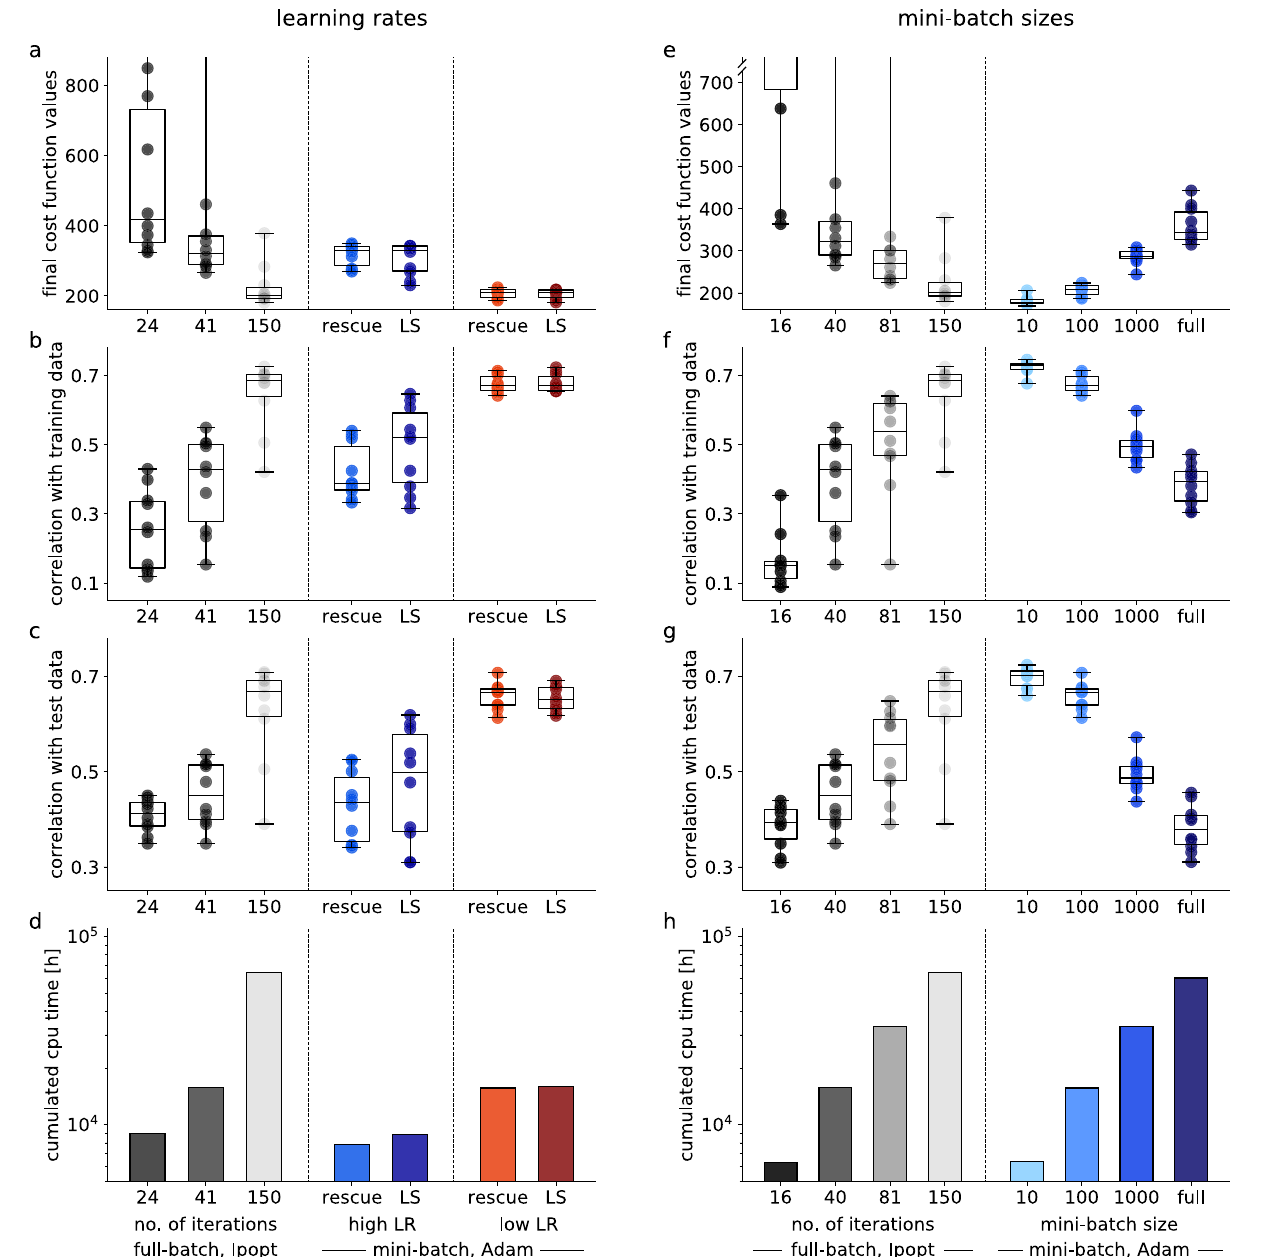
Fig. 6 Comparison of optimization results for the large-scale cancer model, for different hyperparameters. a – c Boxplots of the ten best optimization runs out of 20, started at the same random parameters, for Ipopt (at three different stages of the optimization process to compare performance over computation time) and for mini-batch optimization with different learning rates (LR), with rescue interceptor only (rescue) and with additional line-search (LS). Boxes extend from 25th to 75th percentiles, whiskers show the ranges of the data, and thick lines indicate medians. a Final objective functions values. b Correlation of model simulation with measurement data (training set). c Correlation of model simulation with measurement data (test set). d Total computation time for all 20 optimization runs (lower panel). e – g Boxplots of the ten best optimization runs out of 20, started at the same random parameters, for Ipopt (at four different stages of the optimization process to compare performance over computation time) and for mini-batch optimization with mini-batch sizes (10, 100, 1000 and full-batch, i.e., 13,000). Speci fi cations as described for sub fi gures a – c . e Final objective functions values. f Correlation of model simulation with measurement data (training set). g Correlation of model simulation with measurement data (test set). h Total computation time for all 20 optimization runs (lower